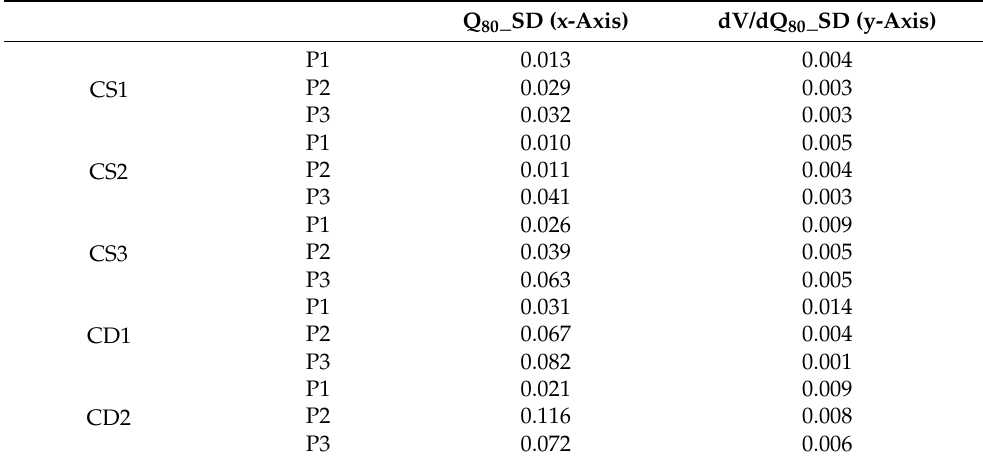
Table 9. Standard deviation of the peak positions (P-1, P-2 and P-3) of the